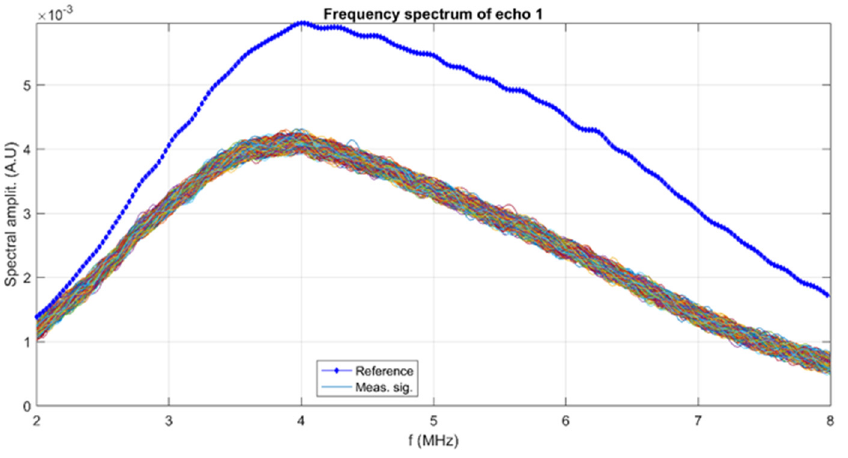
Figure 1. Frequency spectrums for the tested sample (superposing all spectrums) and the reference liquid.